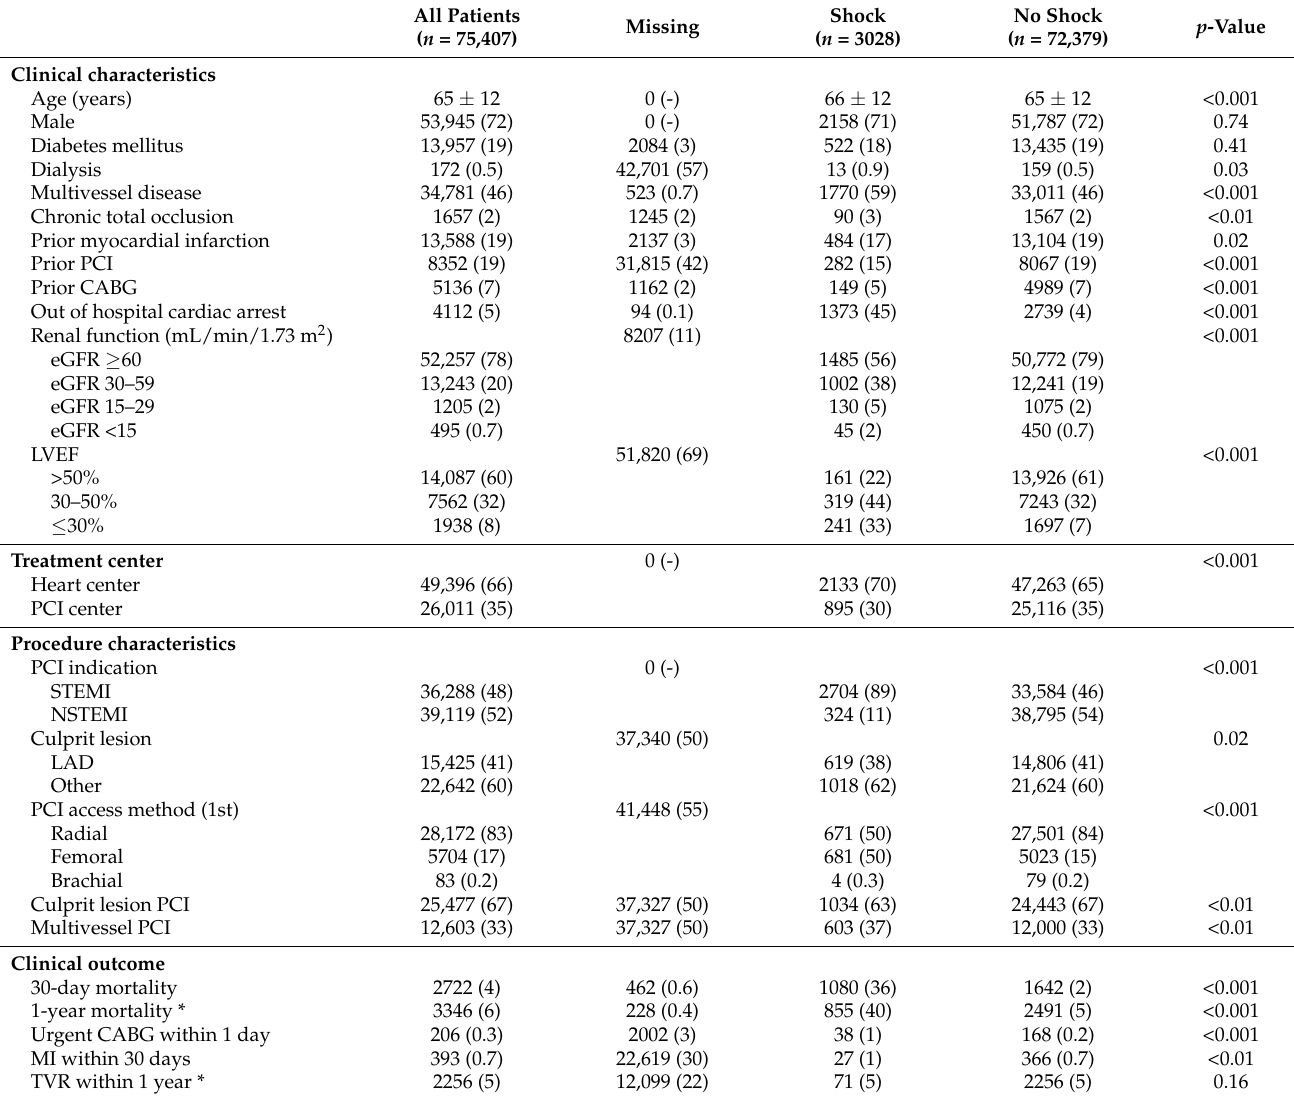
Table 1. Characteristics and clinical outcome of acute coronary syndrome patients treated by percutaneous coronary intervention with and without cardiogenic shock at